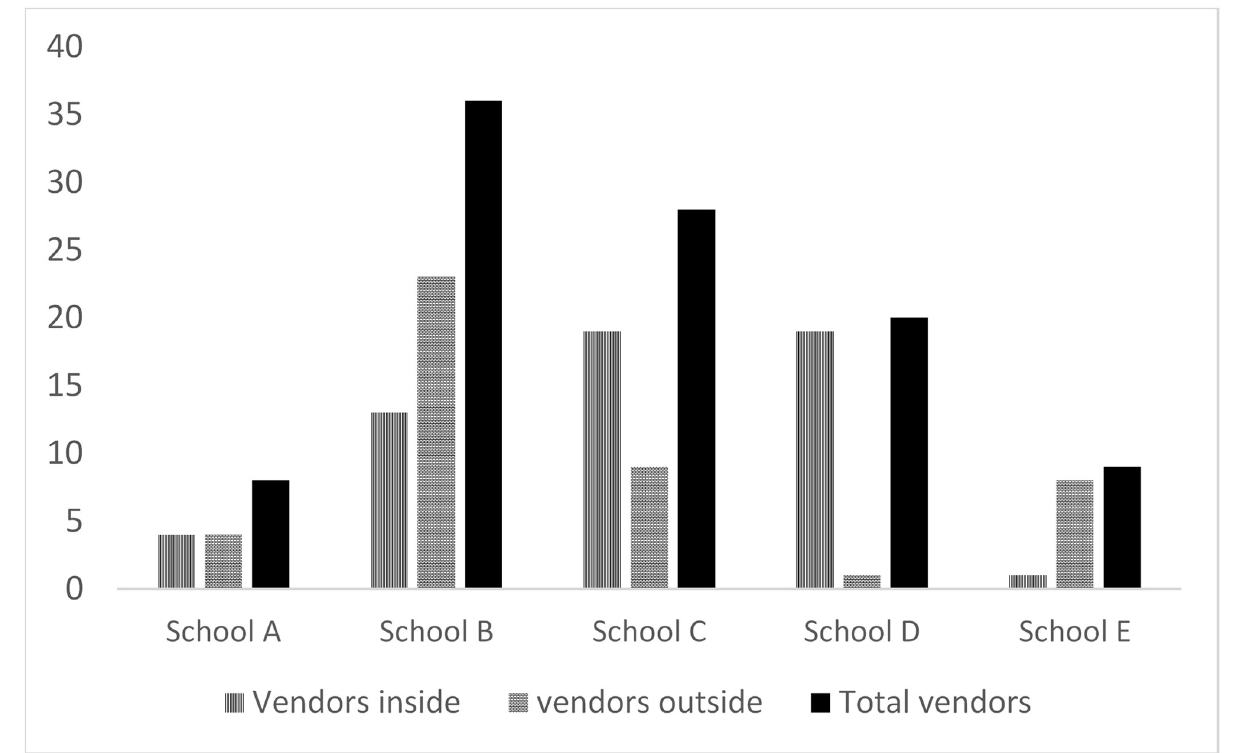
Fig 1. Number of vendors offering foods and drinks to